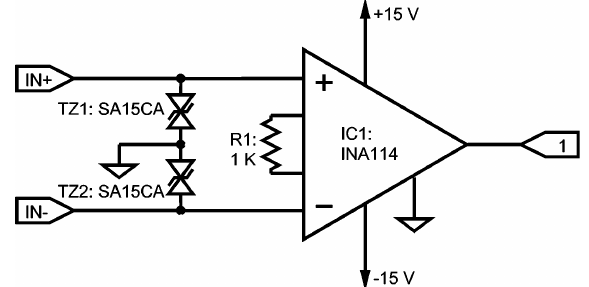
Figure 4. INA 114 instrumentation amplifier with ESD protection; gain = 34 dB, to be assembled near the electrode for differential electrode configuration. Label #1 at the output connects to the notch filter